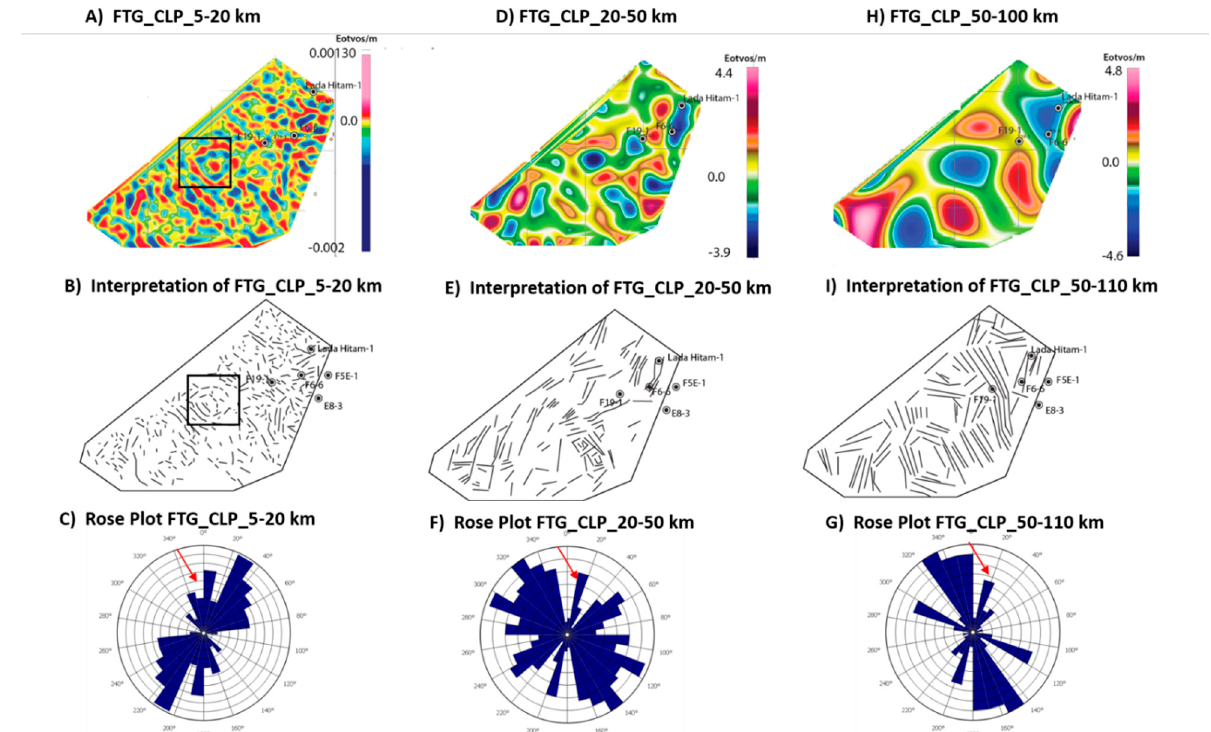
Figure 10. Air-FTG data processed through Contact Lineament Processing (CLP) filter that allows a slicing at different frequencies and wavelengths to capture data at variable depth ranges. ( A ) CLP Map for wavelength 5–20 km; ( B ) Interpretation of structural trend on CLP map of ( A ); ( C ) Rose plot diagram representing NE-SW to N-S orientations from the interpreted structural trends in ( B ). ( D ) CLP Map for wavelengths 20–50 km; ( E ) Interpretation of structural trend on CLP map of ( D ); ( F ) Rose plot diagram representing many directions for the structural trends interpreted in ( E ), with dominant broad NW-SE trend. ( H ) CLP Map for wavelength 50–100 km; ( I ) Interpretation of structural trend on CLP map of ( H ). ( G ) Rose plot diagram representing NW-SE to NNW-SSE orientation from interpretation in ( I ). The rectangle is representing the circular structure discuss in text and the red arrows are highlighting the NE-SW trend that consistently appearing at all depth ranges and should be treated with cautious.